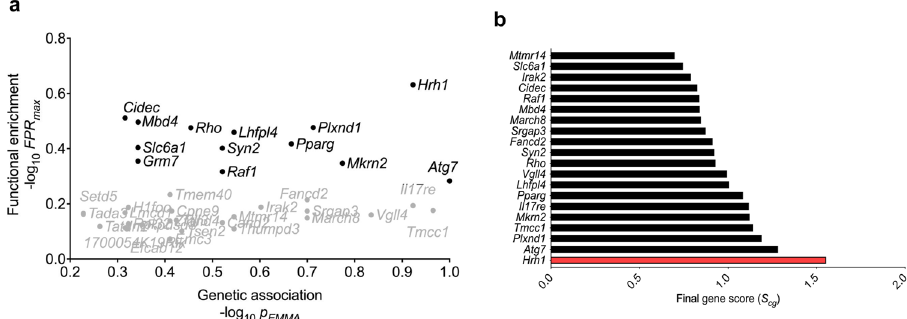
Fig. 3 Integration of genetic and functional mapping approaches to predict candidates for Bphse. a The plot shows normalized negative log-transformed false positive rate of maximum functional enrichment (-log 10 FPR ) on the y -axis. The x -axis denotes the corresponding normalized negative log-transformed genetic association scores. Candidates that were common across both approaches are shown. b The list of gene candidates as predicted by both genetic and functional approaches are ranked using a fi nal gene score ( S cg ) on x -axis and the gene names of top 20 candidates listed on y-axis. Bphs/Hrh1 association is shown in